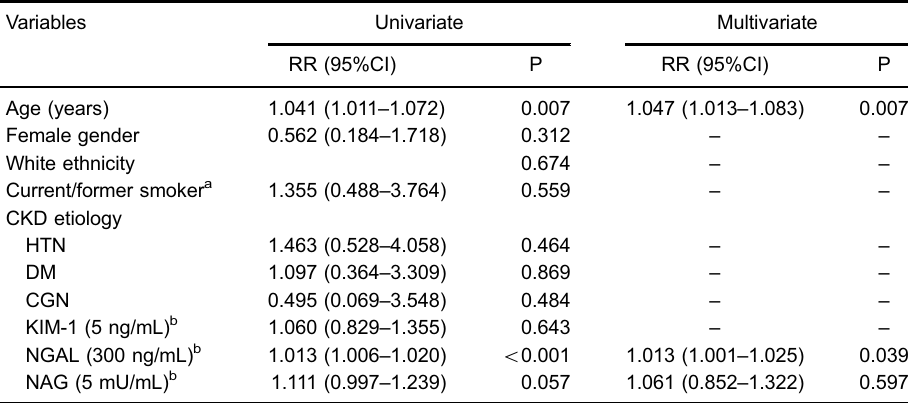
Table 7. Poisson regression analysis to determine factors independently associated with death from any cause in patients on hemodialysis at baseline.